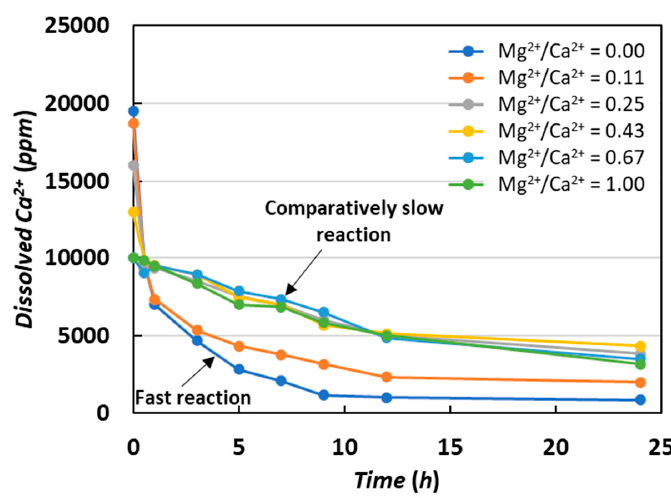
Figure 7. Urea hydrolysis rate with time.